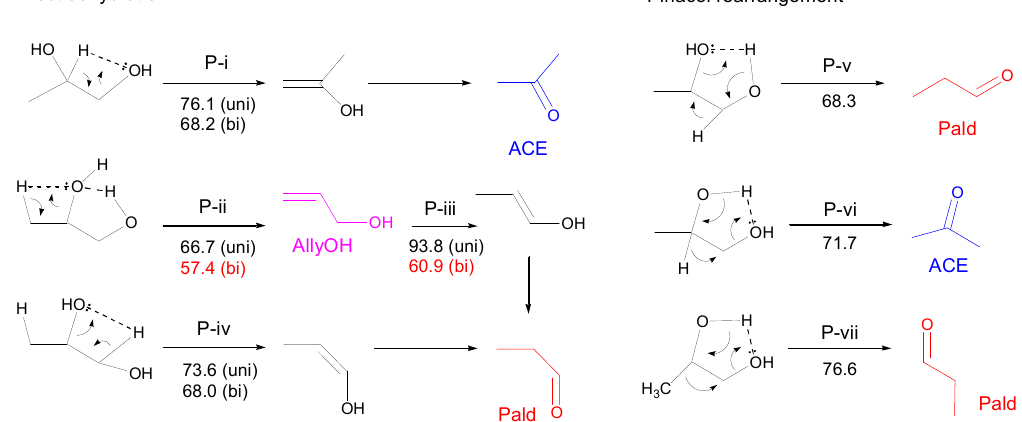
Figure 12. Possible heterolytic dehydration pathways for propylene glycol (PG). The values next to the arrows represent the activation energies (kcal mol − 1 ), as calculated at the MP4(SDQ) // DFT(M06-2X) level. Pald, propionaldehyde; AllyOH, allyl alcohol; ACE, acetone; uni, unimolecular mechanism; and bi, bimolecular mechanism.